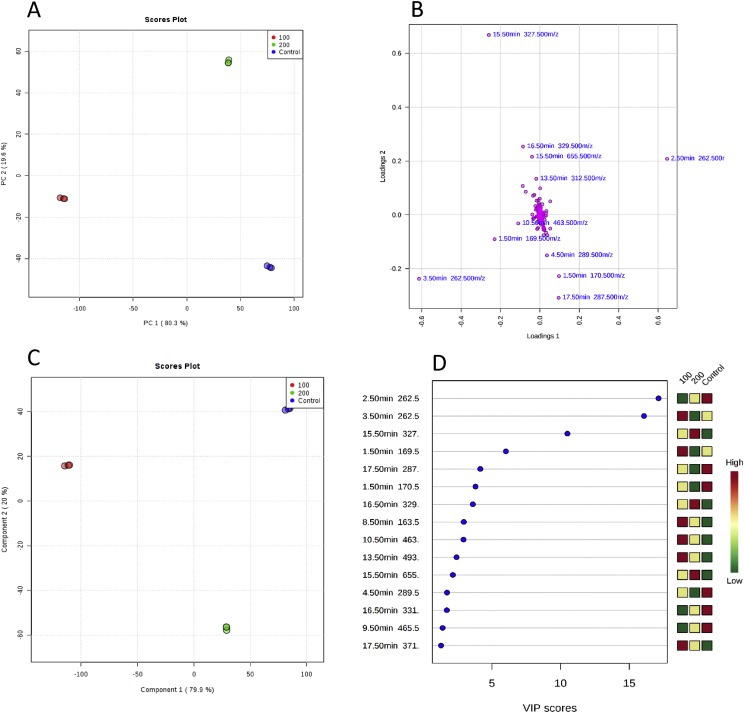
(A) PCA scores plot based on UHPLC−MS data showing separation amongst samples from different irrigation conditions (0 mM - Deep Blue; 100 mM – Red; and 200 mM – Green) for the 2nd harvest, together with their respective 95% confidence regions. The explained variances are respectively 80.3 and 19.6% for PC 1 and PC 2. (B) The corresponding loadings scatter plot showing the compounds (shown as RT) that are correlated to separation in scores plot. (C) PLS-DA of metabolites between groups described above (component 1 and component 2 are 79.9 and 20%, respectively). (D) Variables important in projection (VIP) scores of 15 top contributors (presented as RT) to PLS-DA component 1.